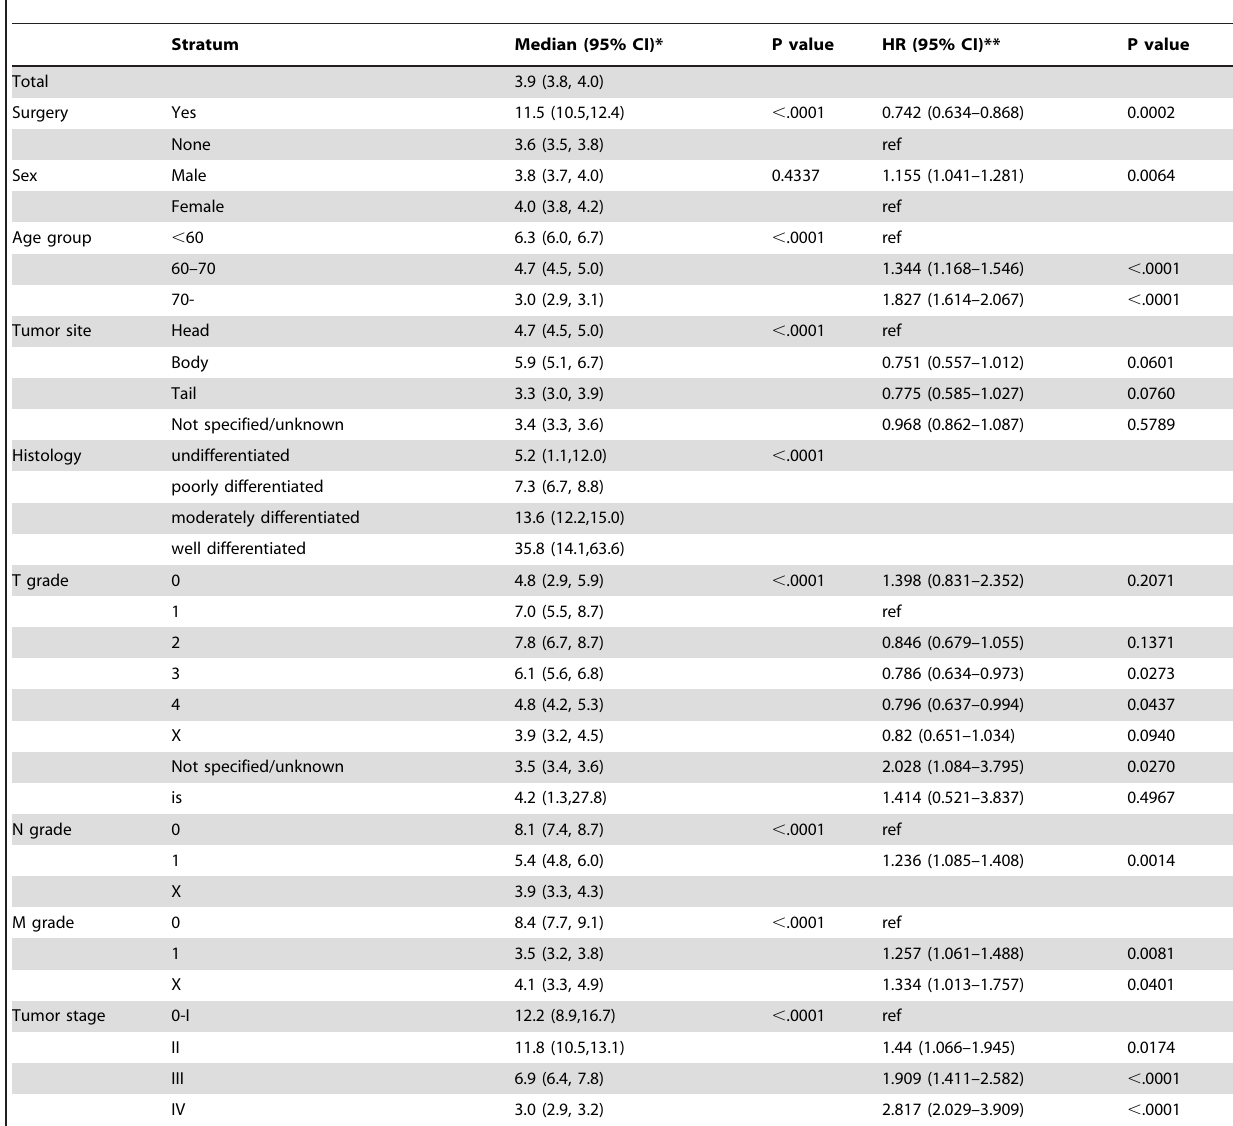
Table 3. The median survival time and influence factors of newly diagnosed pancreatic cancer cases of Shanghai residency during